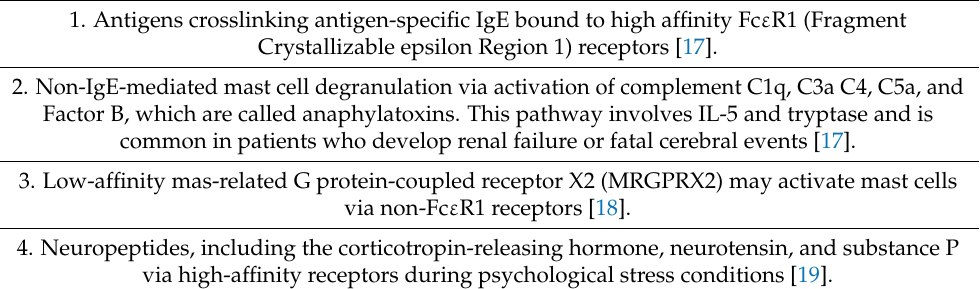
Table 1. Pathways of activation and degranulation of mast